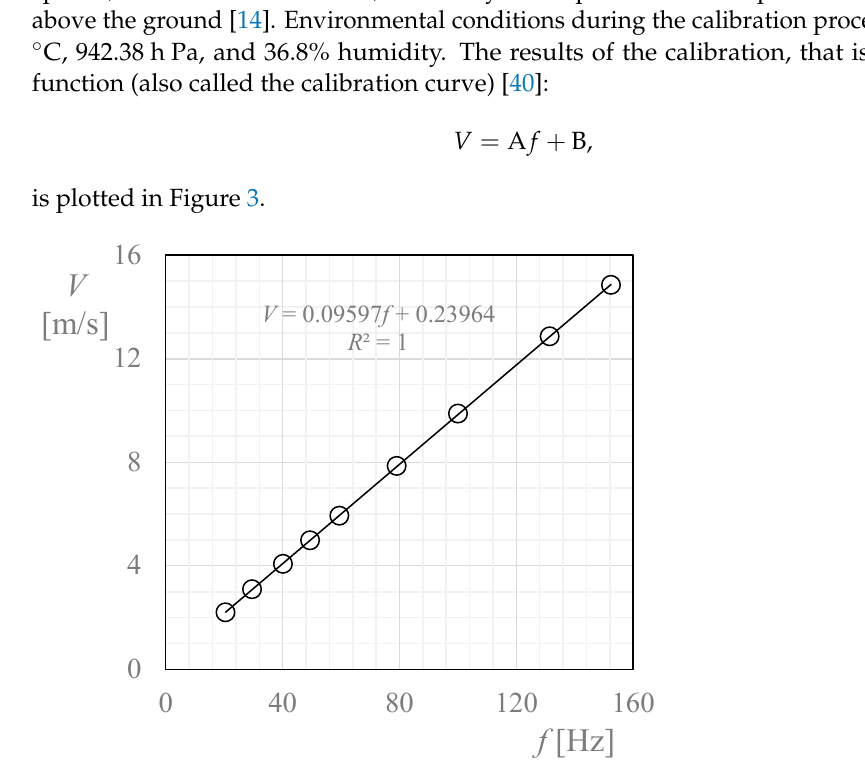
Figure 3. Transfer function (i.e., wind speed, V , vs. output frequency, f ) of the TASEC ‐ Lab cup anemometer measured at the LAC ‐ IDR/UPM calibration lab.